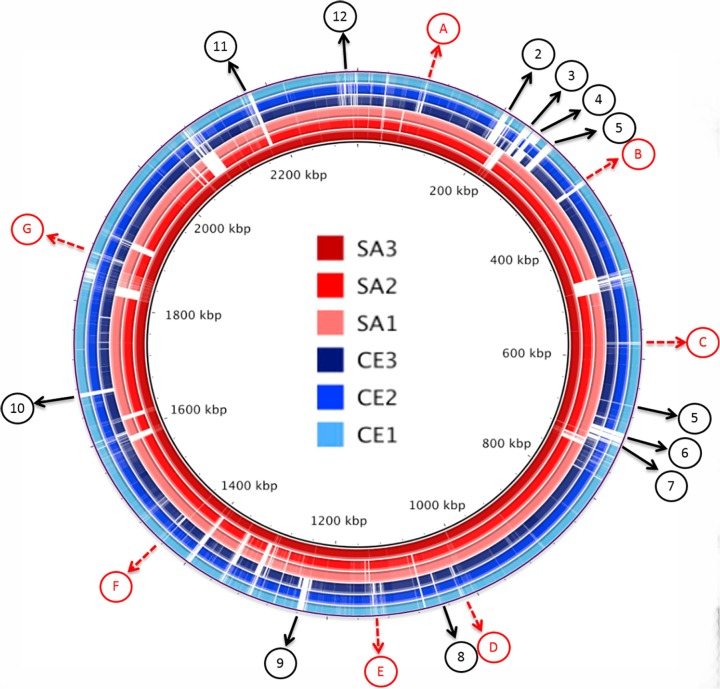
Genome Assemblies of EC Isolates Mapped Against Reference Sequence SA3.Scaffolds of all EC strains were mapped against strain SA3 (including SA3 as a control) using BRIG ring generator and BLASTn. Pathogenic EC strains SA1, SA2, and SA3 are presented in shades of red, commensal strains CE1, CE2, and CE3 are presented in shades of blue. Genetic sequences of less than 50% homology are plotted in white on each ring. 19 regions (labeled A-G and 1–12) are conserved in pathogenic EC, but not conserved in commensal EC (white areas). Regions A-G do not contain predicted coding sequence and represent inversions, rearrangements and insertions. ACT plots for these regions are provided in supplemental material (S2 Fig). The location on the SA3 chromosome map and the leading BLASTn result for each CDS are provided in supplemental material (S1 Table).